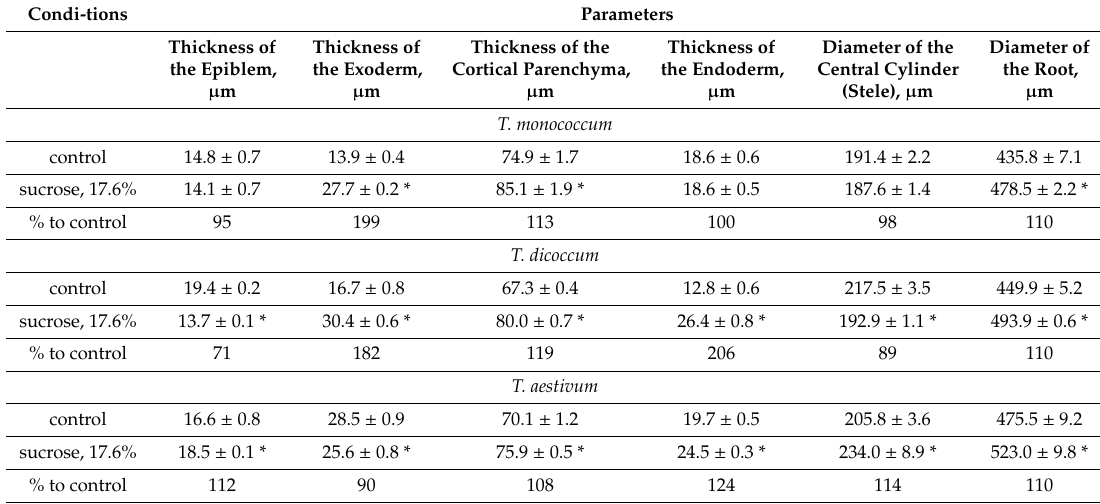
Table 1. Influence of water deficit on the anatomical parameters of the roots of di ff erent wheat species. Condi-tions